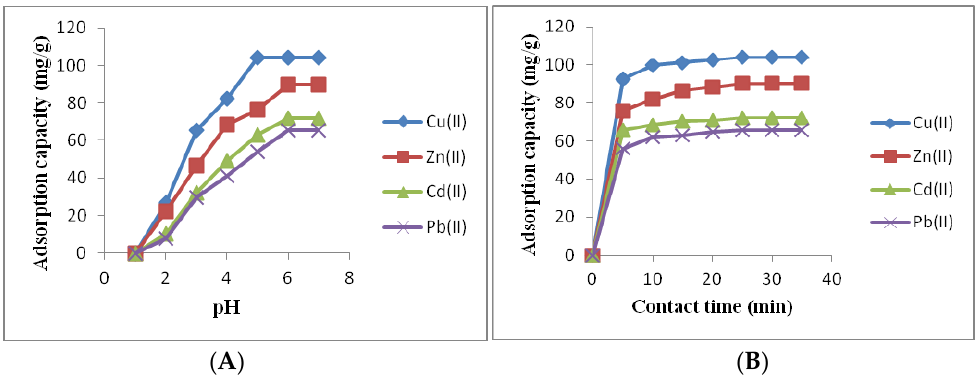
Figure 6. ( A ) Effect of pH; ( B ) Effect of shaking time on the adsorption capacity of Cu(II), Zn(II), Cd(II) and Pb(II).